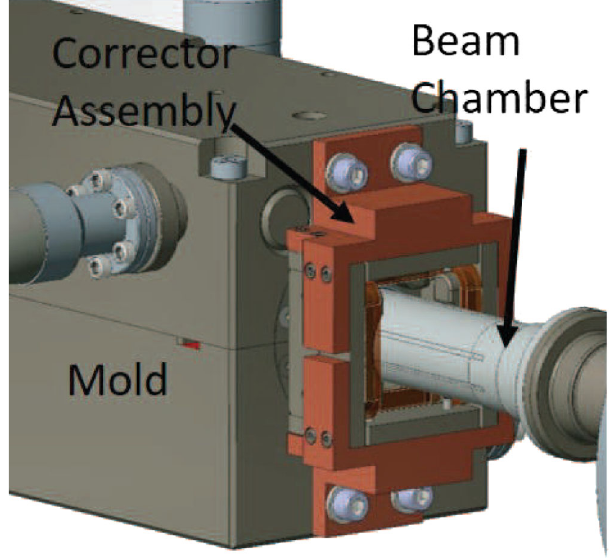
FIG. 12. Rendering of the HSCU assembly showing the corrector magnets mounted to the end of the mold as well as the beam chamber extending outside of the assembly.